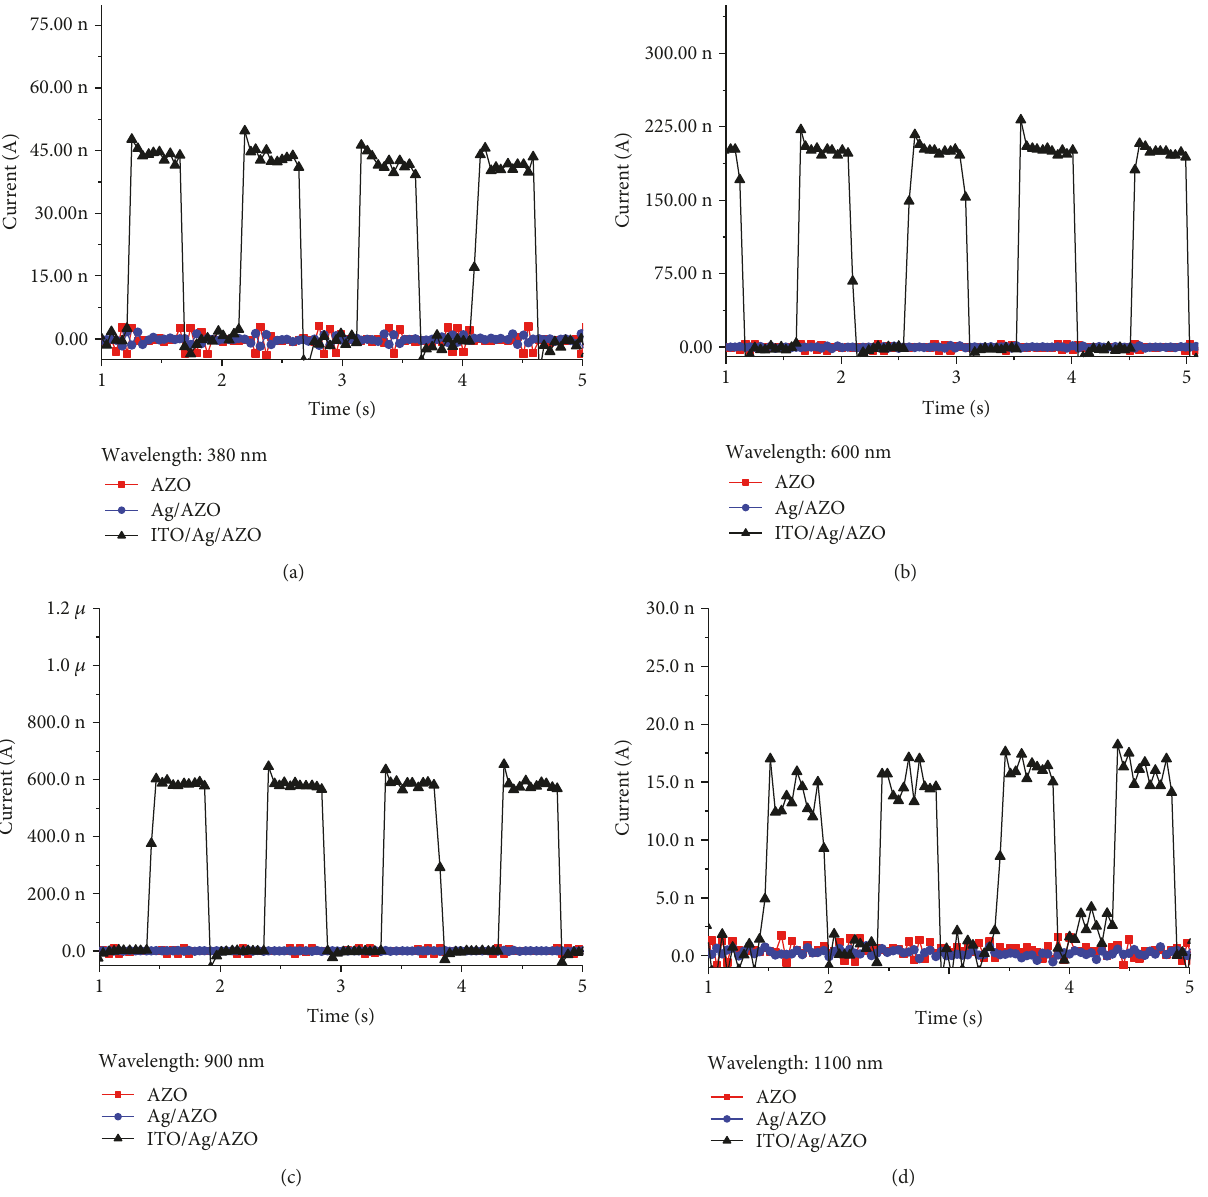
Figure 7: Photoresponses of AZO, Ag/AZO, and ITO/Ag/AZO devices at a wavelength of (a) 380nm, (b) 600nm, (c) 900 nm, and (d)